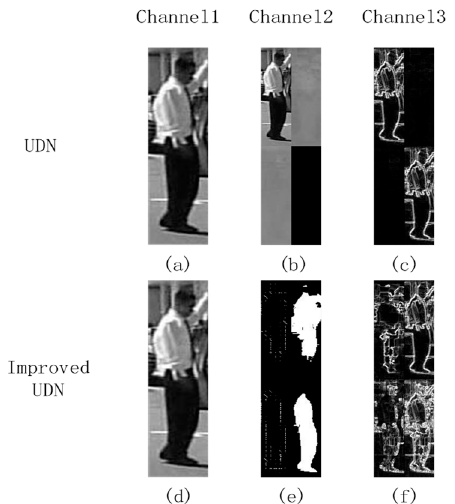
Figure 2. Input channels for Unified Deep Networks (UDN) and improved UDN. ( a ) The Y channel in YUV color space. ( b ) Concatenation of the Y channel, U channel, and V channel with zero padding. ( c ) Concatenation of four Sobel edge maps. The former three are obtained from three channel images in YUV color space, the fourth edge map is obtained by choosing the maximum magnitudes from the first three edge maps. ( d ) V channel in HSV color space. ( e ) Concatenation of two HOG feature maps and two Grabcut feature maps. ( f ) Concatenation of four Sobel edge maps. The former three are obtained from three channel image in HSV color space, the fourth edge map is obtained by choosing the maximum magnitudes from the first three edge maps.